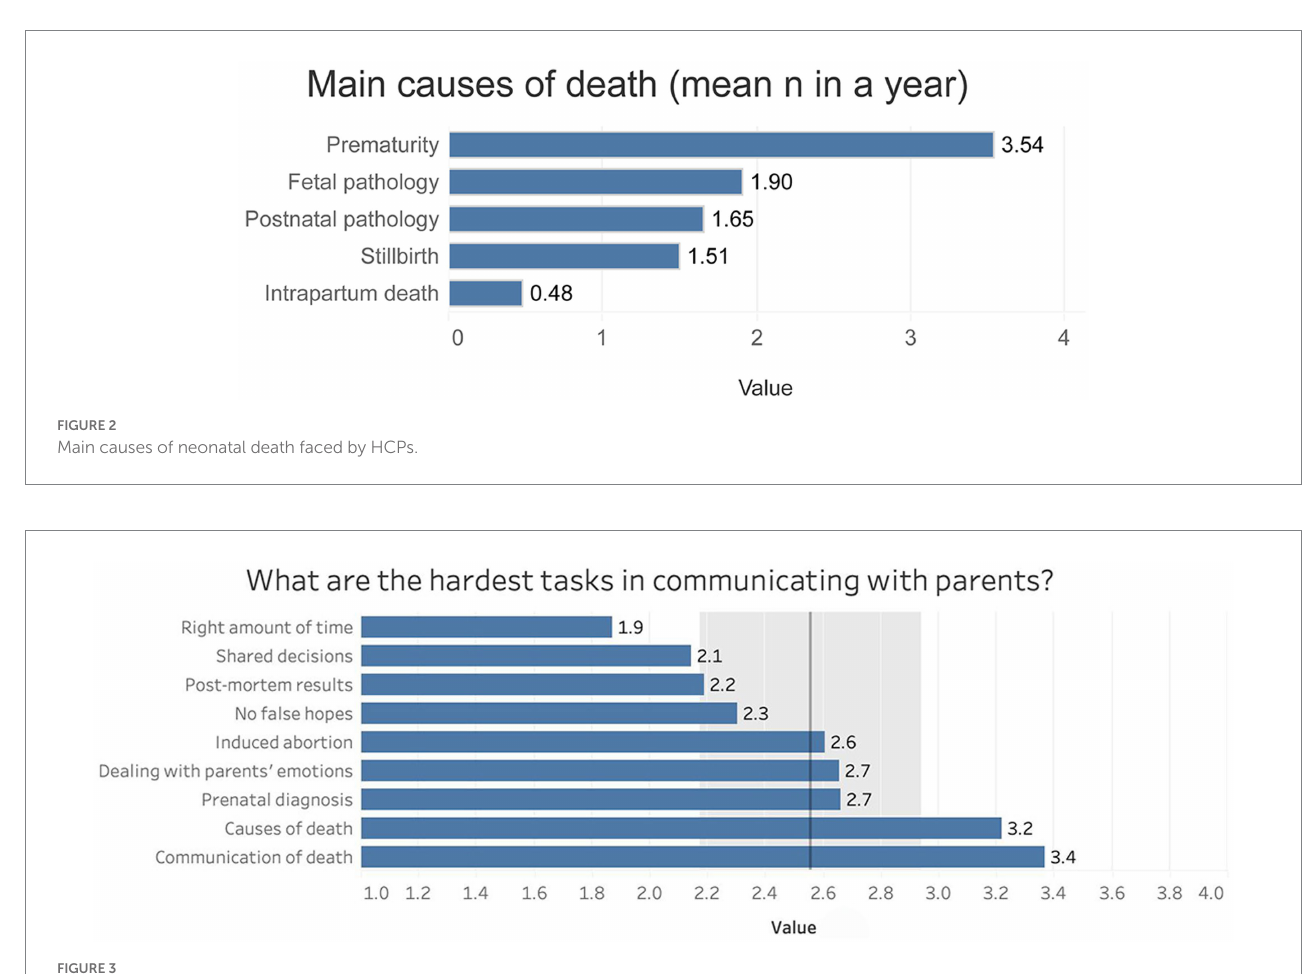
FIGURE 3 The hardest tasks for HCPs in communicating with